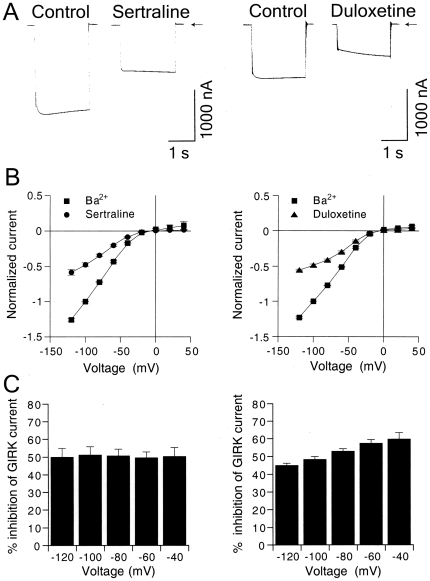
Characteristics of the inhibitory effects of sertraline and duloxetine on GIRK currents.(A) Representative GIRK1/2 currents elicited by a voltage step to −100 mV for 2 s from a holding potential of 0 mV in the presence or absence of 30 µM sertraline (left) or 30 µM duloxetine (right) applied for 3 min. Current responses were recorded in an hK solution that contained 96 mM K+. Arrows indicate the zero current level. (B) Current-voltage relationships of the magnitudes of 3 mM Ba2+-sensitive currents and the magnitudes of currents reduced by 30 µM sertraline (left, n = 9) or 30 µM duloxetine (right, n = 6) in oocytes that expressed GIRK1/2 channels. Current responses were normalized to the 3 mM Ba2+-sensitive current component measured at a membrane potential of −100 mV (1851.0±220.4 nA, n = 15). (C) Percentage inhibition of GIRK1/2 channels by 30 µM sertraline or 30 µM duloxetine over the voltage range of −120 to −40 mV. The magnitudes of inhibition of GIRK currents by 30 µM sertraline (left, n = 9) and duloxetine (right, n = 6) at the end of the voltage pulses were compared with the 3 mM Ba2+-sensitive current components. All values are expressed as mean ± SEM.